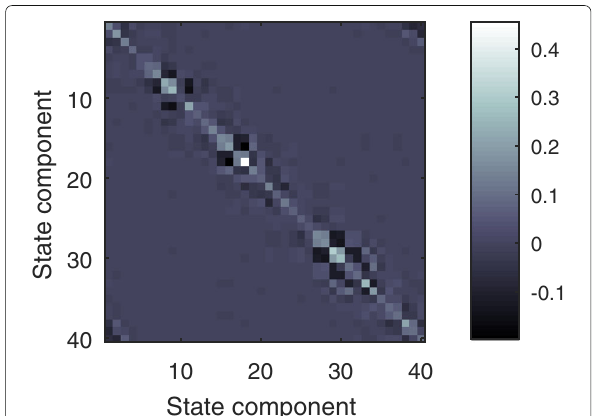
Fig.16 Prediction covariance ¯ P k | k − 1 for k = 30 obtained from an EnKF with N = 1000. The banded structure justifies the use of localization